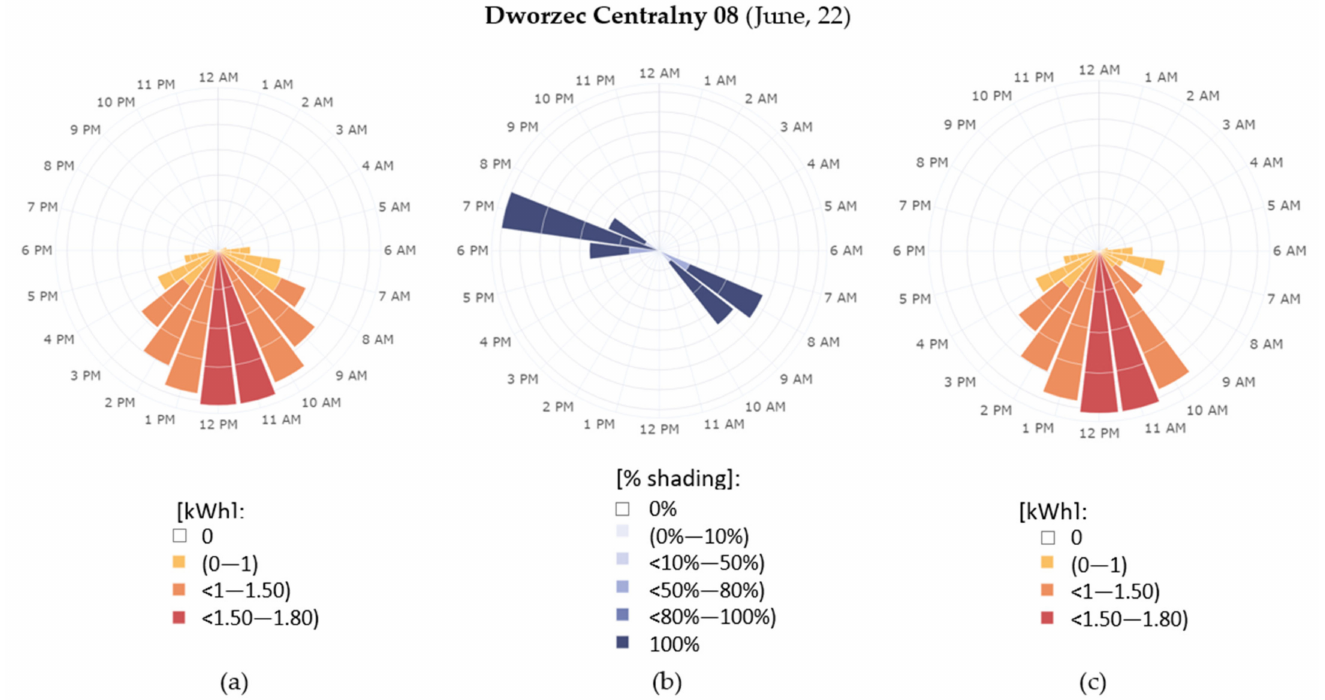
Figure 23. Results obtained for the shelter roof in the neighbourhood of Dworzec Centralny 08 tram stop for 22 June 2020: ( a ) solar potential in kWh per stop shelter roof area; ( b ) percentage loss due to shelter shading; ( c ) actual solar potential including shading (kWh) per stop shelter roof area. The maximum value is about 1.8 kWh (6.48